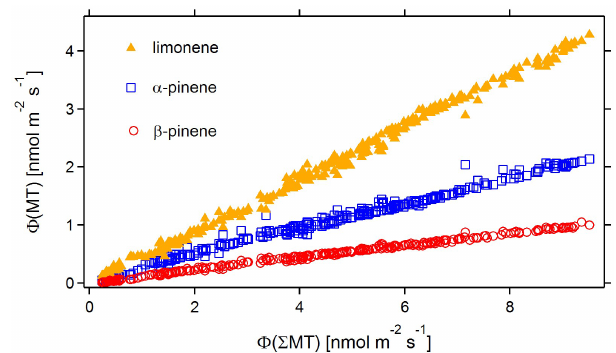
Figure 2. Correlation plot of emission rates measured for Holm oak, experiment 2. Only data measured at a PAR of 440µmolm − 2 s − 1 and a chamber temperature of 22 ◦ C are plotted. The variation of emission rates is caused by changes in soil moisture. The high coef- ficients of determination ( R 2 > 0.95) indicate that only the strengths of the emissions was changed but not the emission